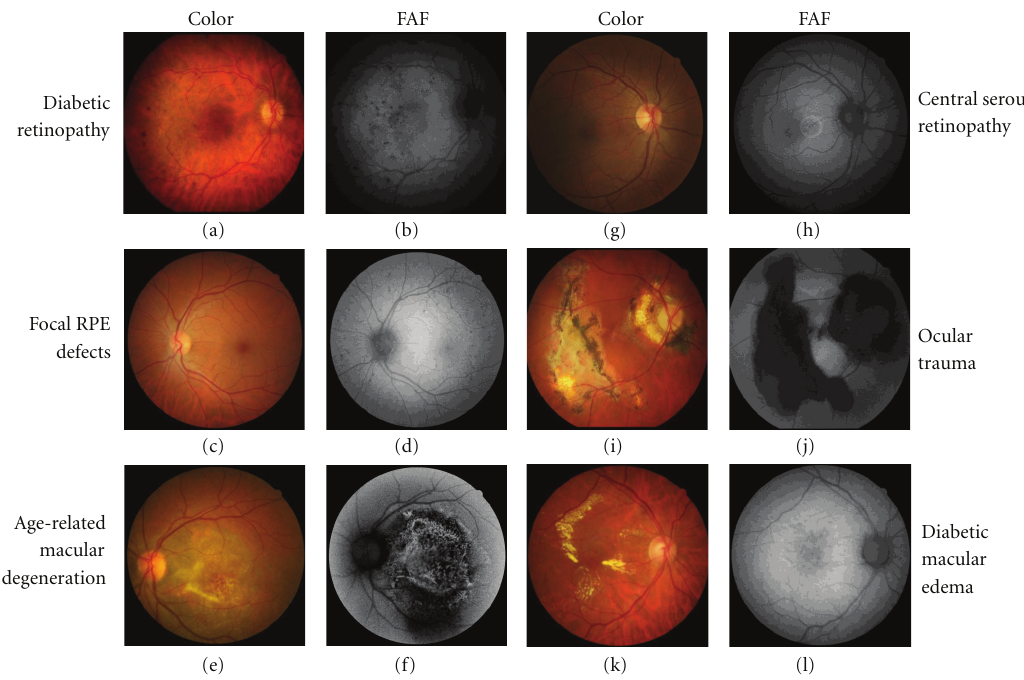
Figure 2: (a, b) Compared to color, FAF imaging identified a larger number of dot-blot hemorrhages and microaneurysms and was superior at outlining RPE disturbances. (c, d) Perifoveal RPE hypopigmentation was evident on the color image, while extensive focal RPE defects were seen on FAF imaging. (e, f) FAF versus color imaging showed more detail in terms of the extent of RPE disturbance. (g, h) A faint circular lesion was seen nasal to the fovea on color imaging. FAF imaging was superior to color imaging at characterizing the full extent of this lesion by delineating RPE hyperfluorescence and damage. (i, j) Extensive fibrosis was appreciated on color imaging, while FAF imaging further delineated an extensive area of RPE degeneration. (k, l) Diabetic macular edema with extensive hard exudates were clearly identified on color but not FAF